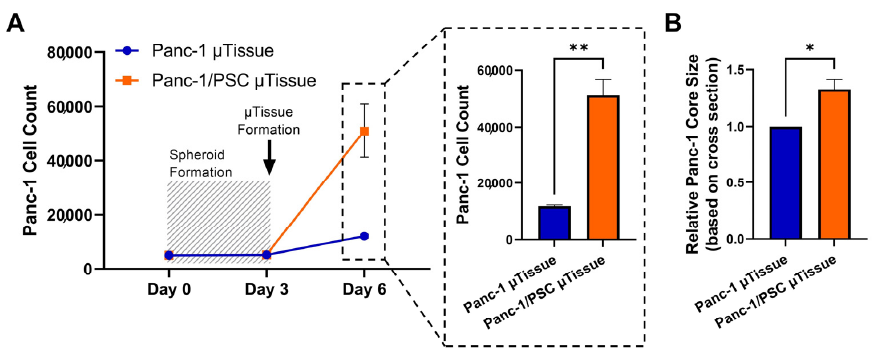
Figure 6. Proliferation of Panc-1 cells in Panc-1/PSC µ tissues. ( A ) Panc-1 cell count in Panc-1 µ tissues and Panc-1/PSC µ tissues determined by flow cytometry. ( B ) Size of Panc-1 core in Panc-1 µ tissues and Panc-1/PSC µ tissues based on HE stained tissue sections (relative size calculated from the measured cross-section area in mm 2 ). Data represent mean ± standard error of the mean for at least 3 independent experiments. Statistical analysis was performed by two-tailed Student’s t-test. * p < 0.05, ** p < 0.01.